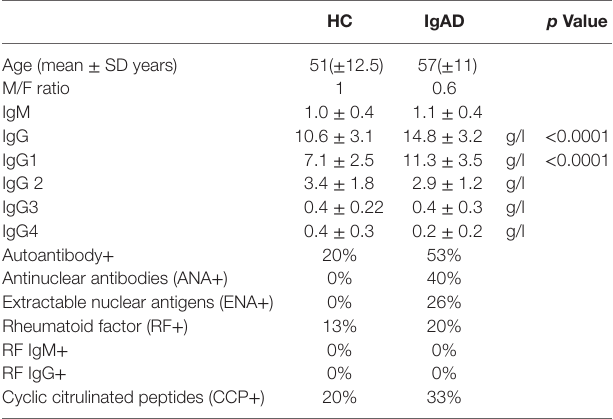
TaBle 1 | Demographics of healthy controls (HC) and IgAD patients